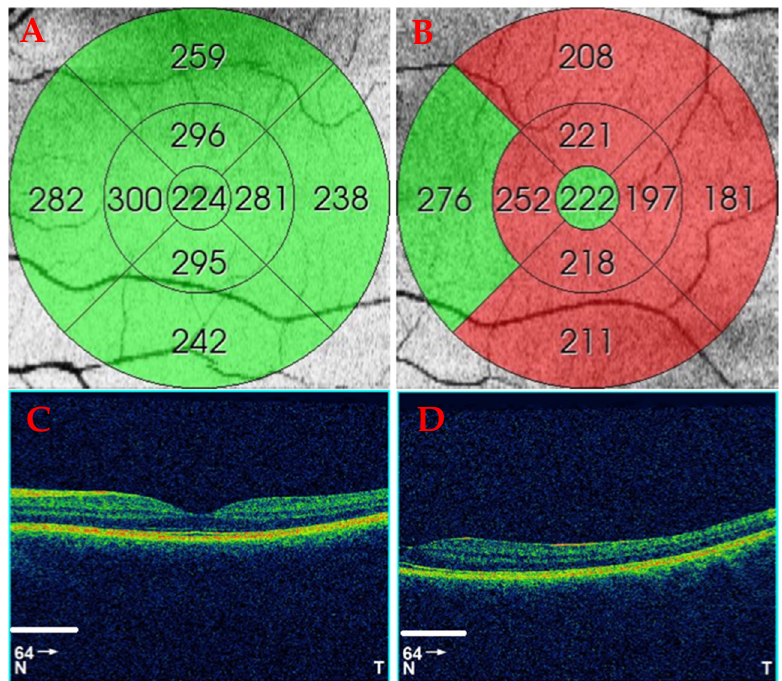
Figure 1. (Up) The 9 circular areas for a left eye. The 1 mm diameter central area ( C ), the 3 mm parafoveal ring with four areas: temporal inner (T3), superior inner (S3), nasal inner (N3) and inferior inner (I3). The 6 mm perifoveal ring: temporal outer (T6), superior outer (S6), nasal outer (N6), and inferior outer (I6). Optical coherence tomography (OCT) images for a left eye. The 9 ETDRS areas in the central retina ( A ) and the peripheral retina ( B ). Central retina B-scan ( C ) and peripheral temporal retina B-scan ( D ). Scale bars 1000 µm.